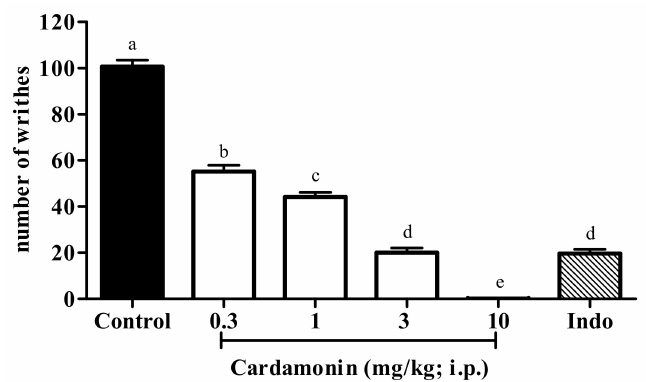
Figure 1. E ff ect of cardamonin (0.3, 1, 3 and 10 mg / kg; i.p.) against acetic acid-induced nociception. Each column represents the mean ± S.E.M. of six mice. Control group received only the vehicle (ethanol: Tween 20: distilled water in 5:5:90, v / v ) used to dilute the compound. Indomethacin (Indo; 10 mg / kg;